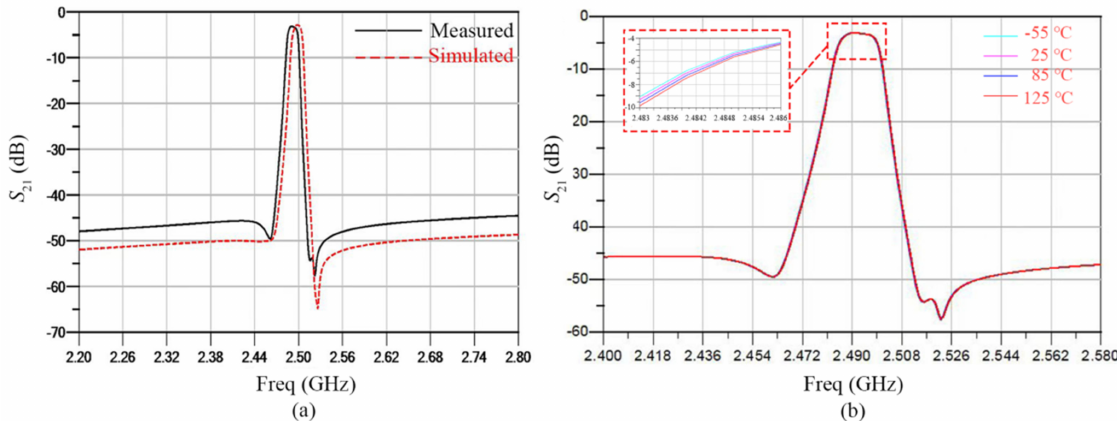
Figure 13. ( a ) Test and simulation comparison diagram of the TC-FBAR. ( b ) Frequency response diagram of the temperature characteristics of the